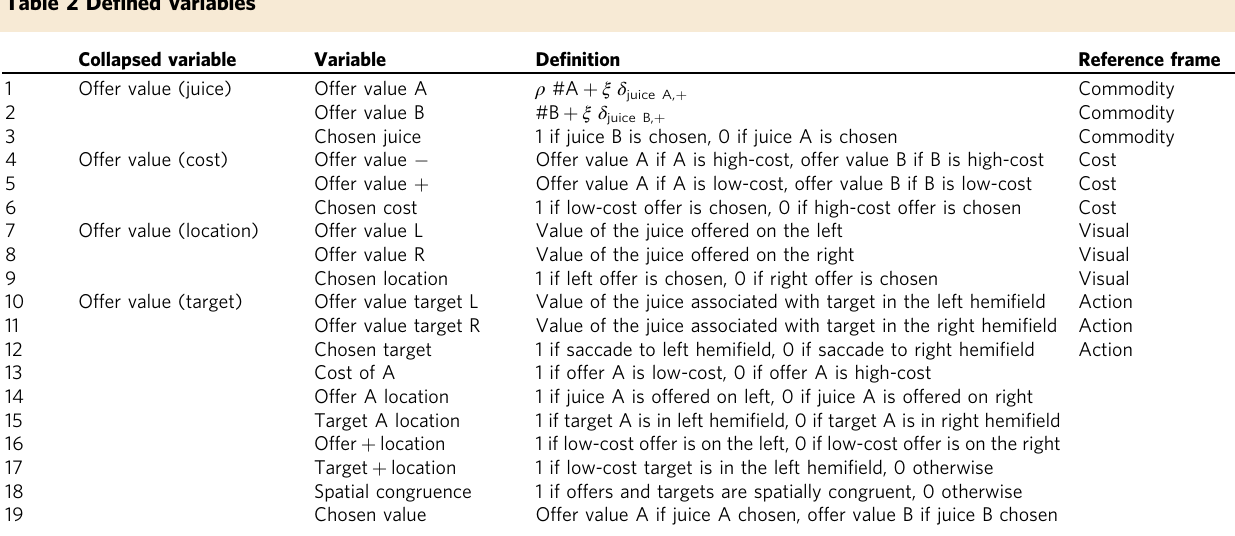
Table 2 De fi ned